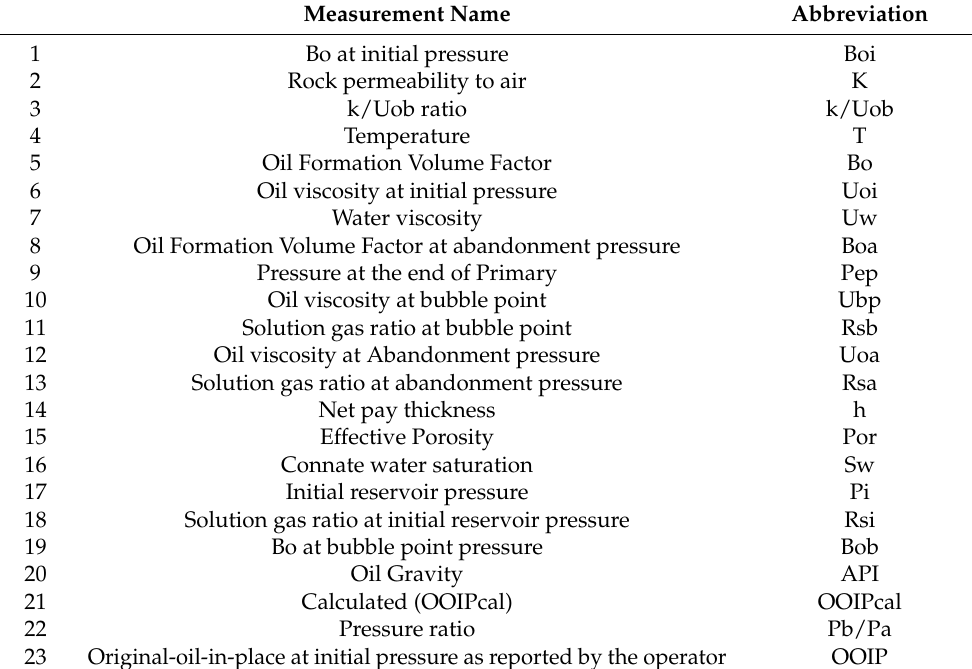
Table 2. Measurements of the reservoir [3,23,27].